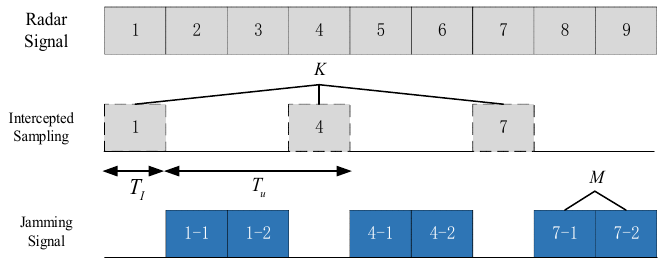
Figure 1. The jamming principle of ISRJ.